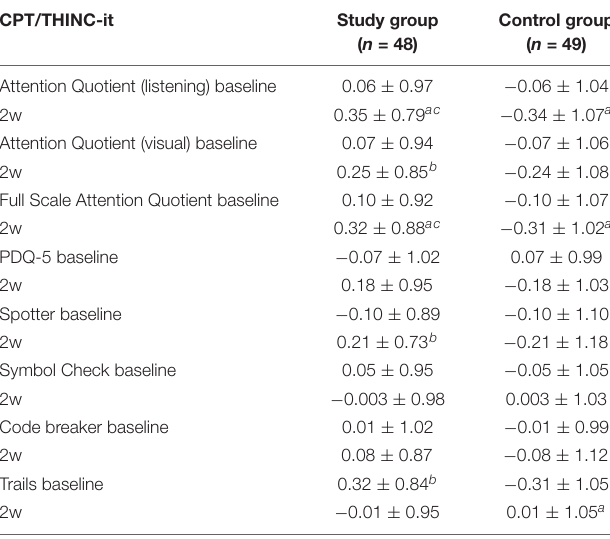
TABLE 3 | Neuropsychological rating of patients. CPT/THINC-it Study group